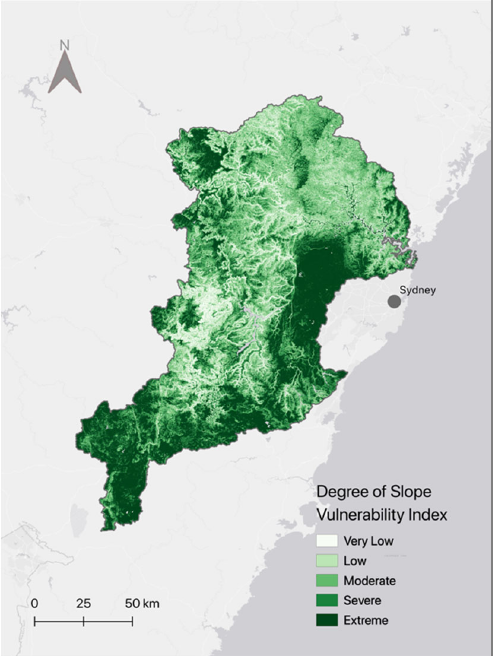
Figure 6. Map depicting degree of slope Vulnerability across the Hawkesbury ‐ Nepean Catchment after standardising with Fuzzy membership.